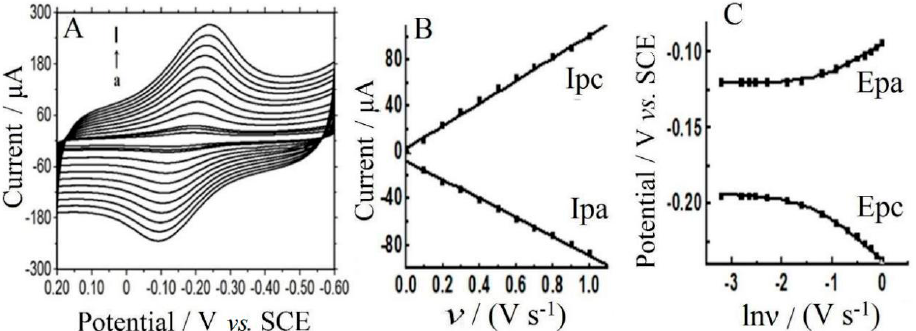
Figure 5. (A) Effect of scan rates ( υ ) (from a → l as 50, 80, 100, 200, 300, 400, 500, 600, 700, 800, 900, 1000 mV·s − 1 ) on electrochemical responses of CTS/CMS-Hb/CILE in pH 3.0 PBS; ( B ) Plot of the redox peak currents against υ ; ( C ) plot of the redox peak potentials against ln υ .